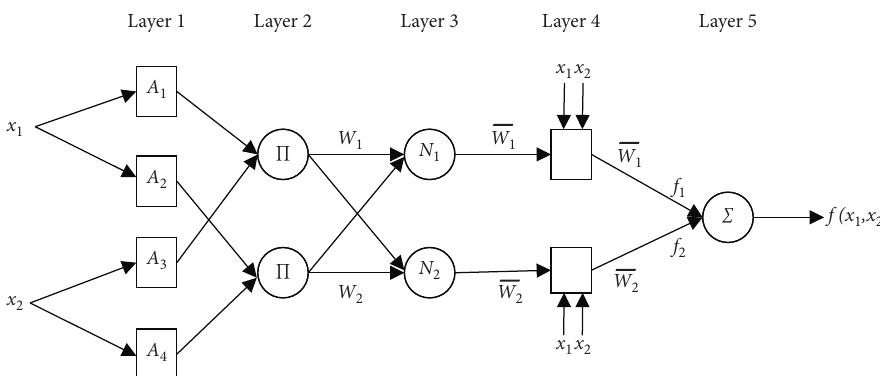
Figure 5: The ANFIS structure architecture